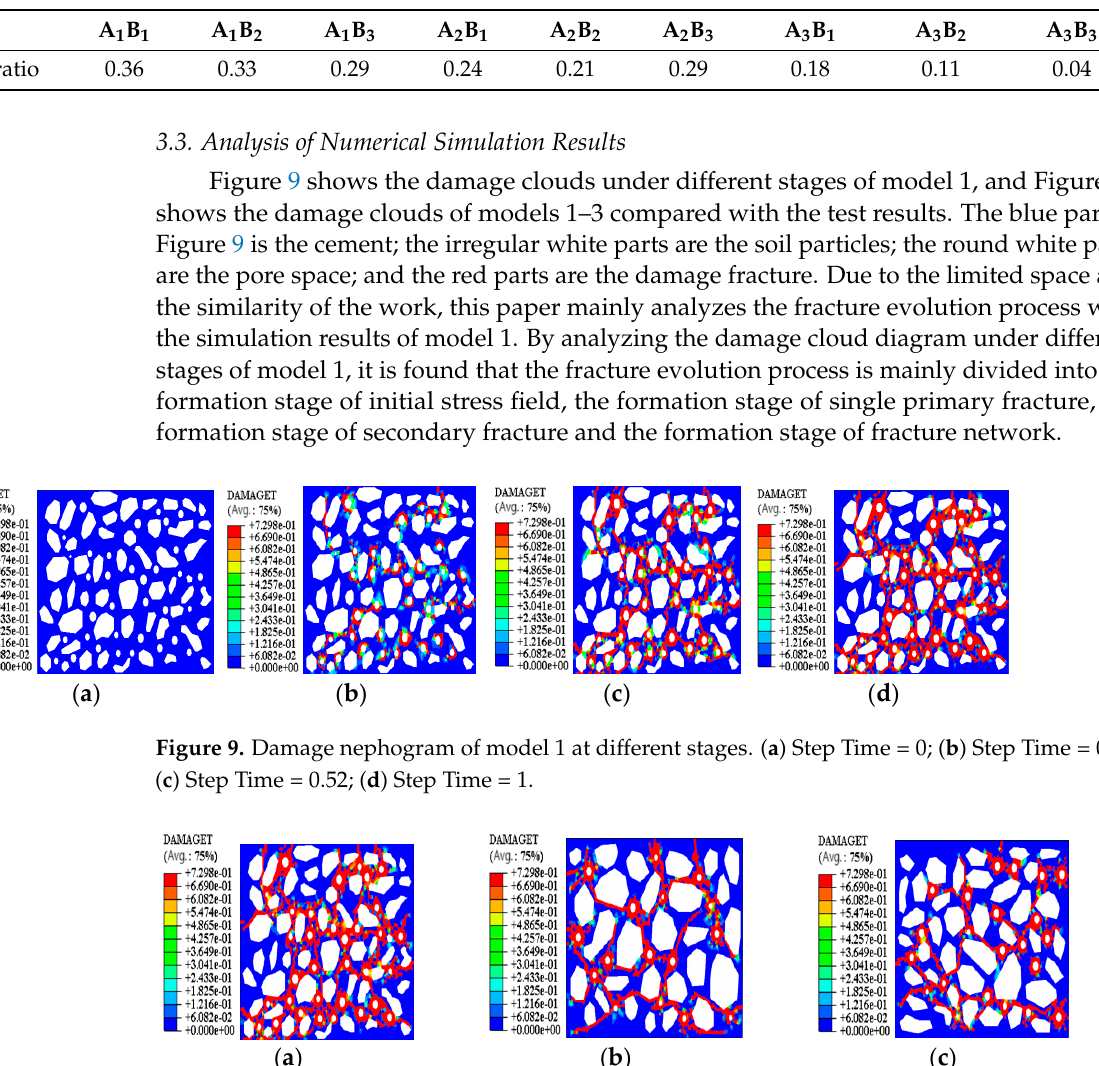
Table 4. SEM image fracture area ratio.